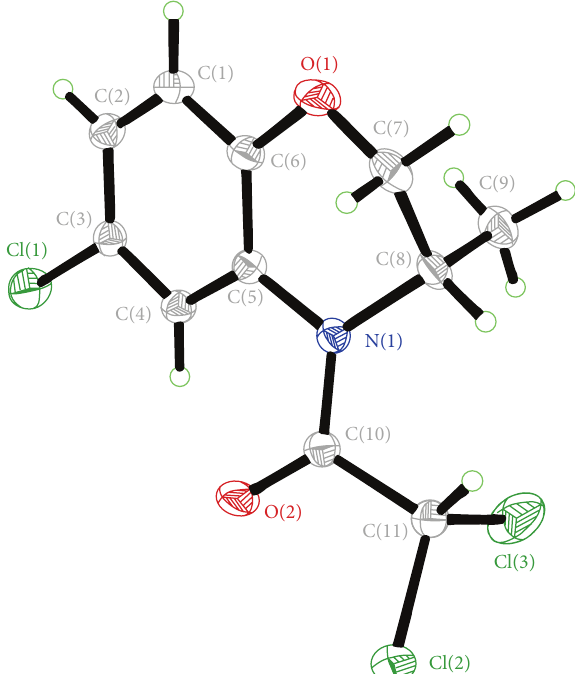
Figure 1: Molecular structure for title compound at 30% probability level.